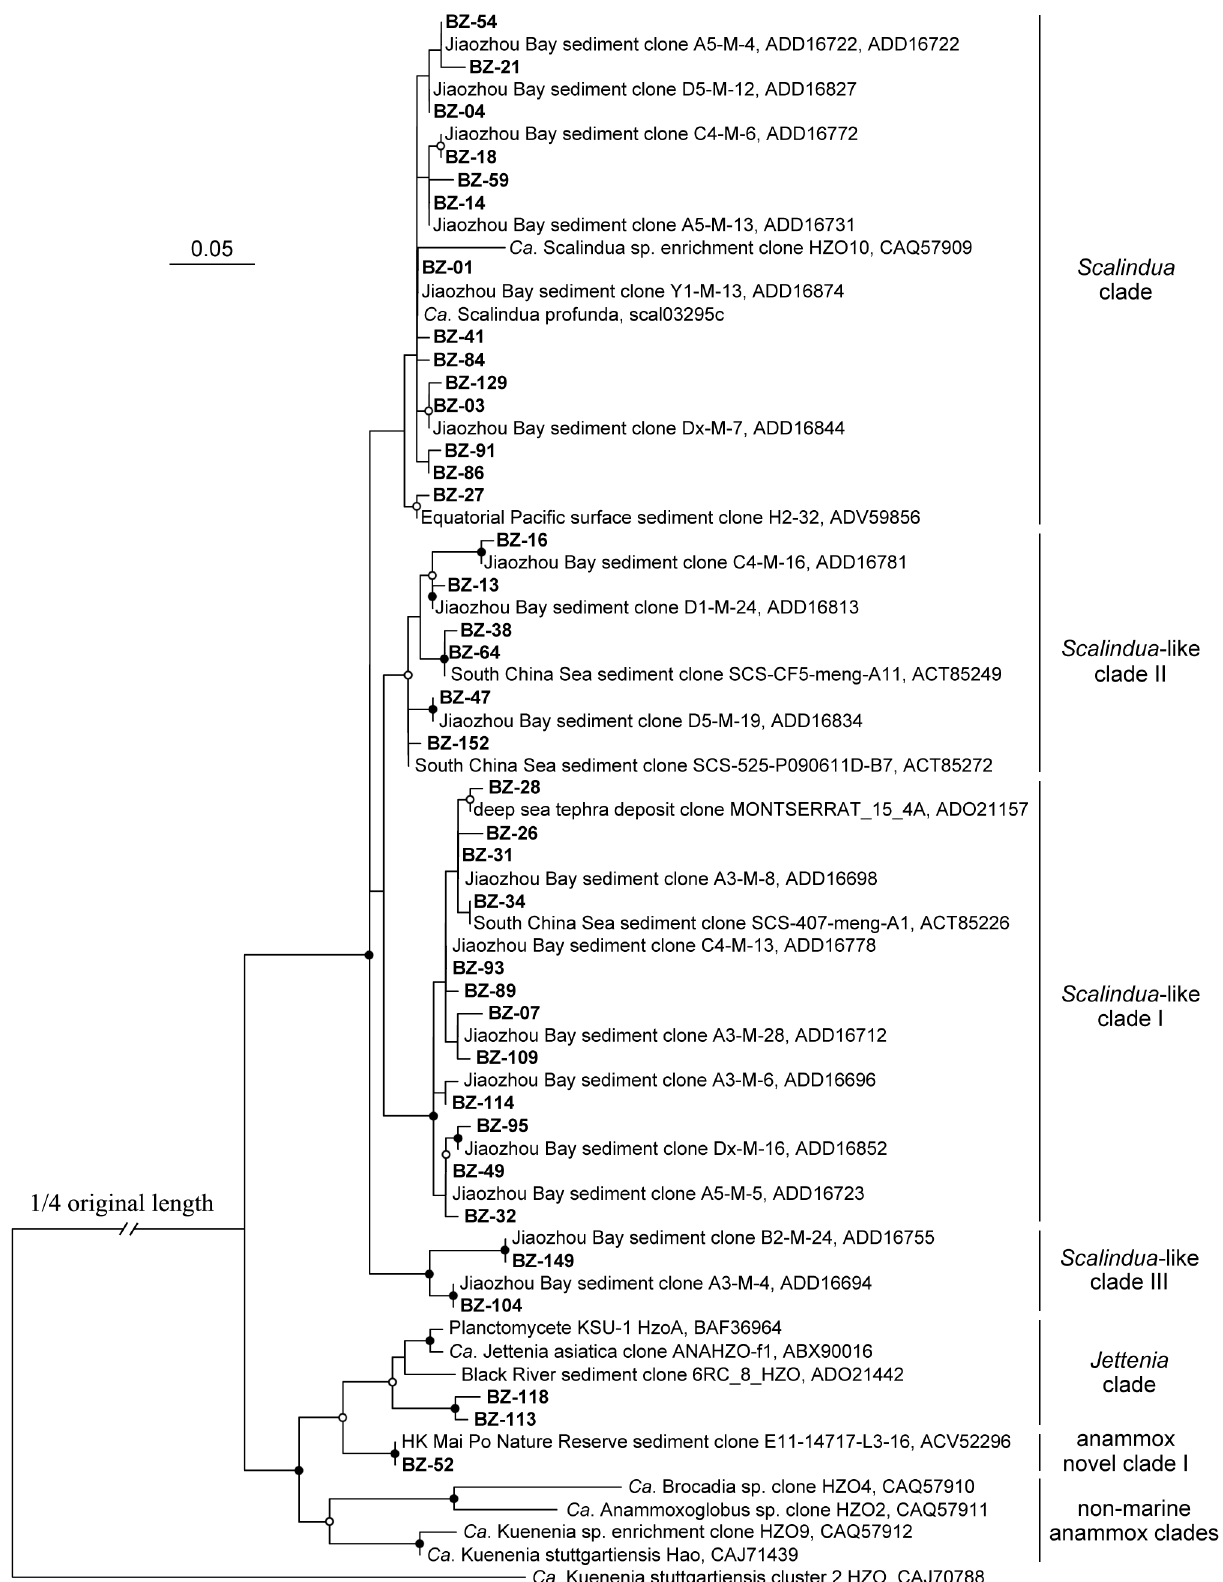
Figure 4. Phylogenetic analysis of representative Hzo protein sequences deduced from obtained Bohai Sea hzo gene sequences. The tree branch distances represent amino acid substitution rate, and the scale bar represents the expected number of changes per homologous position. The cluster 2 Hzo sequence (GenBank accession CAJ70788) was used as outgroup. Bootstrap values higher than 70% of 100 resamplings are